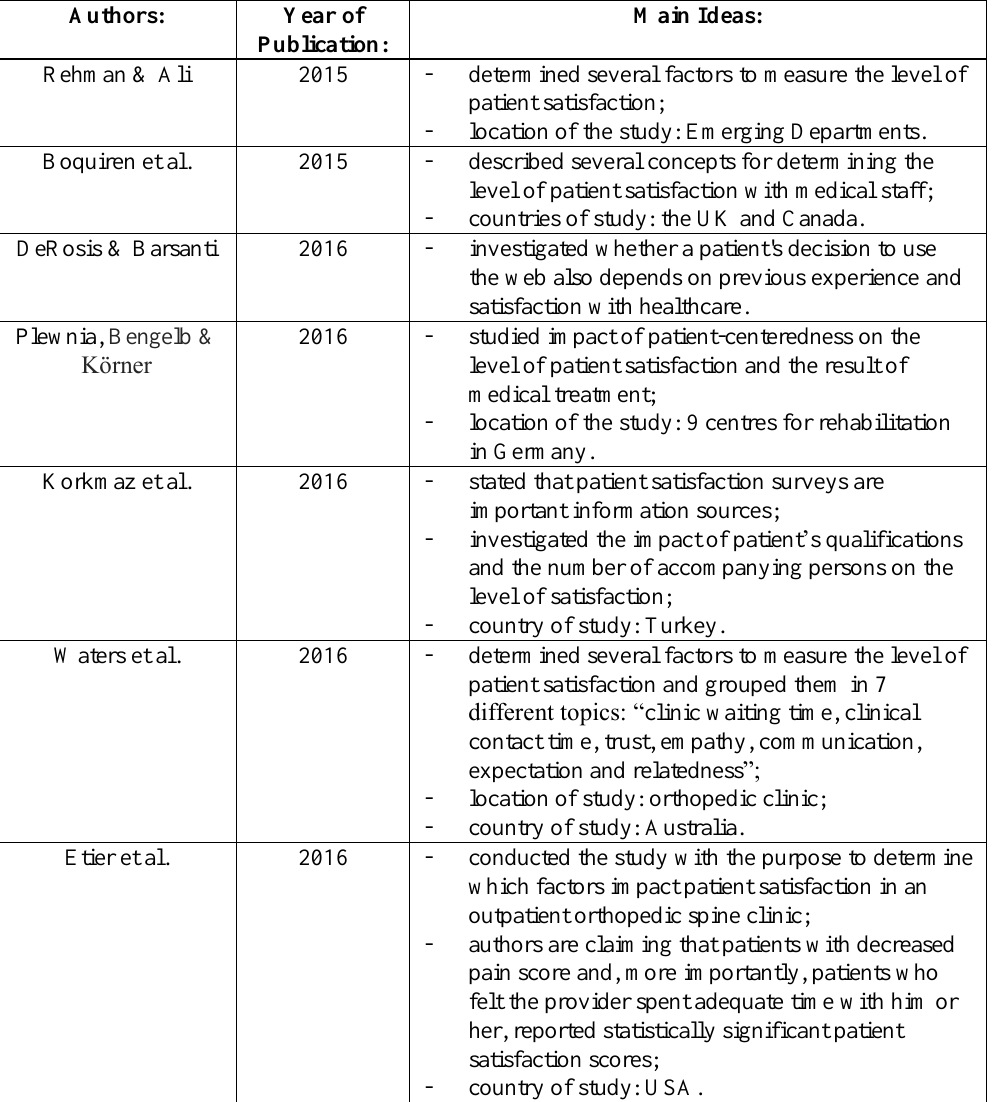
Table 1. Overview of the Recent Studies Regarding Patient Satisfaction with Medical